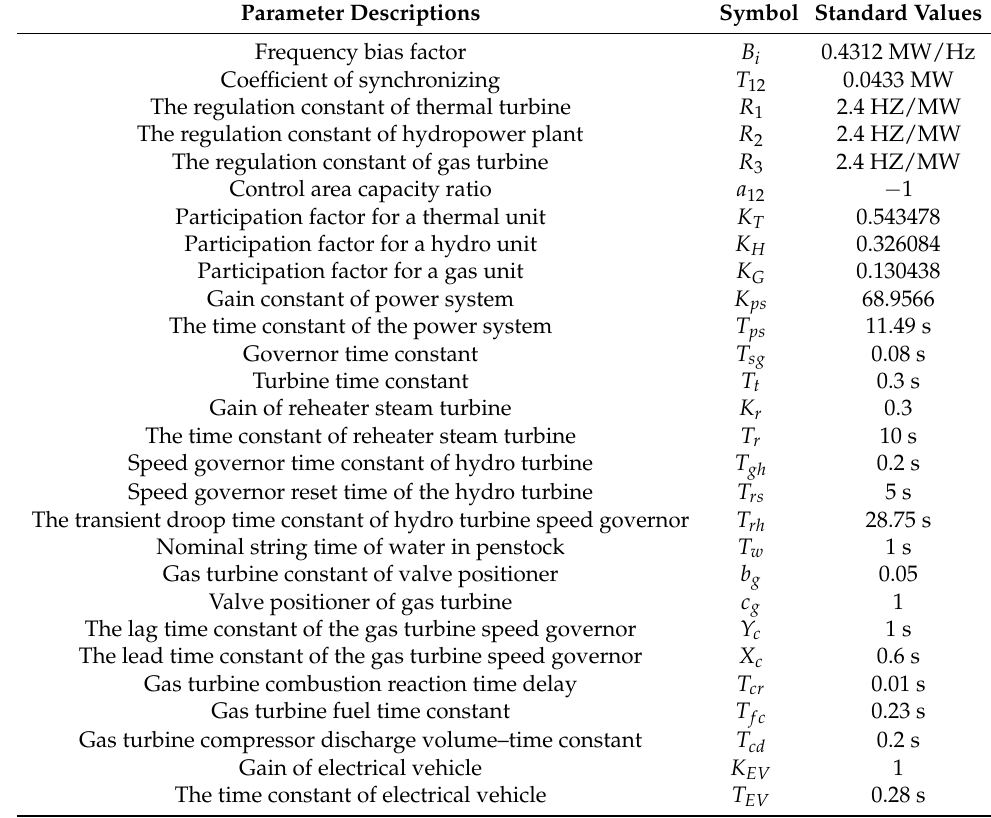
Table 3. The standard parameter values of the two interconnected identical areas